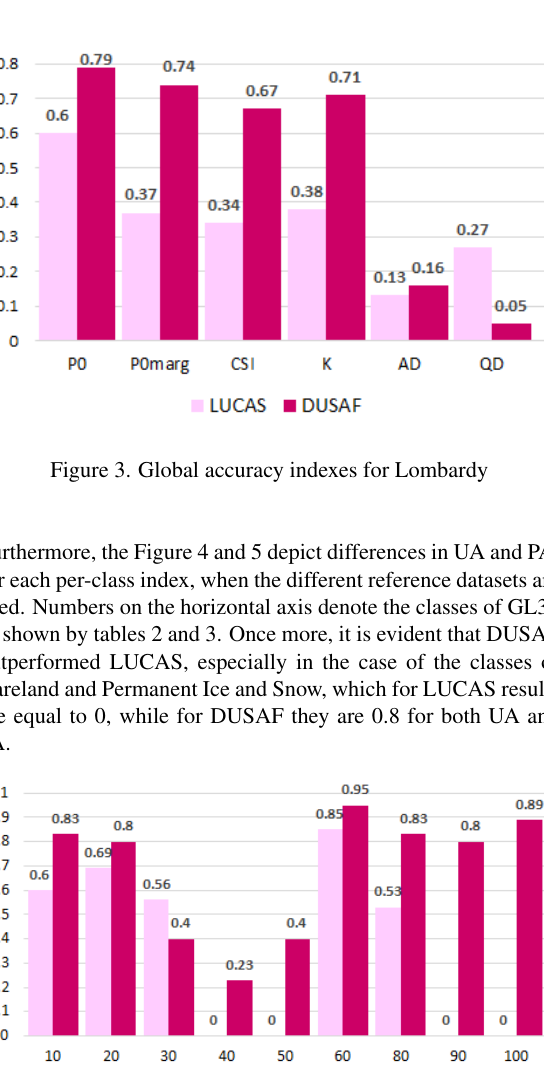
Figure 4. User’s accuracy for each LC class in Lombardy